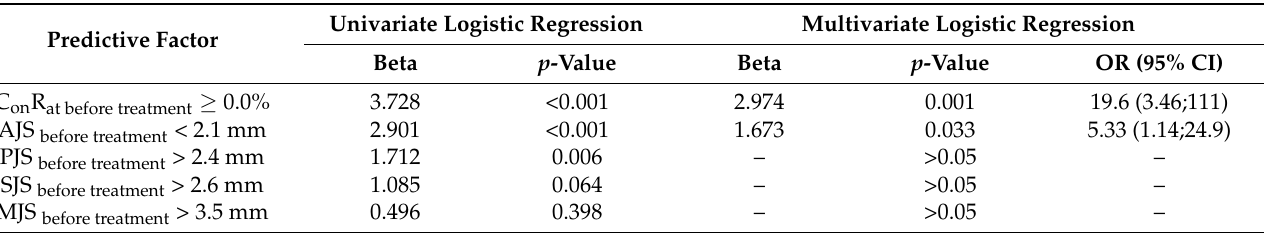
Table 13 presents the results of the univariate and multivariate logistic regre- ssion analyses. Table 13. The results of the univariate and multivariate logistic regression